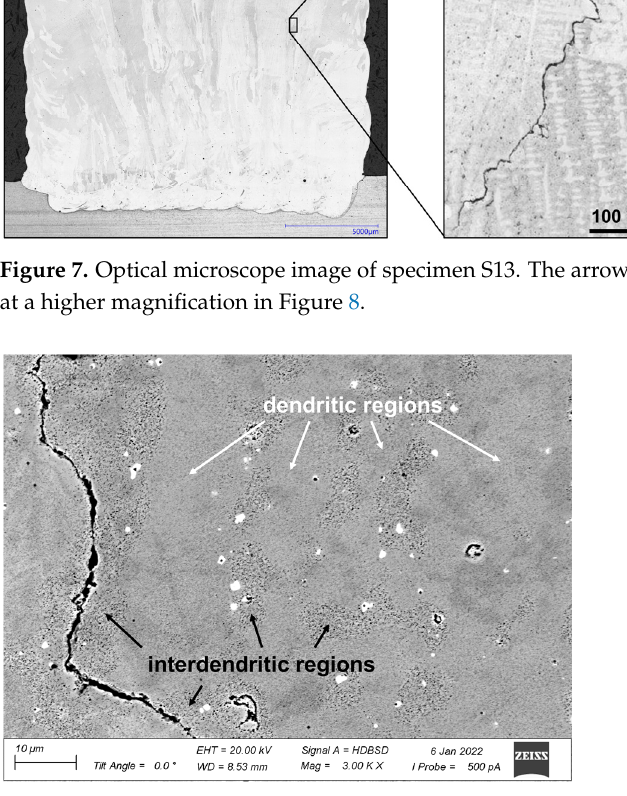
Figure 8. Backscatter electron image of a cracked grain boundary and its surroundings.